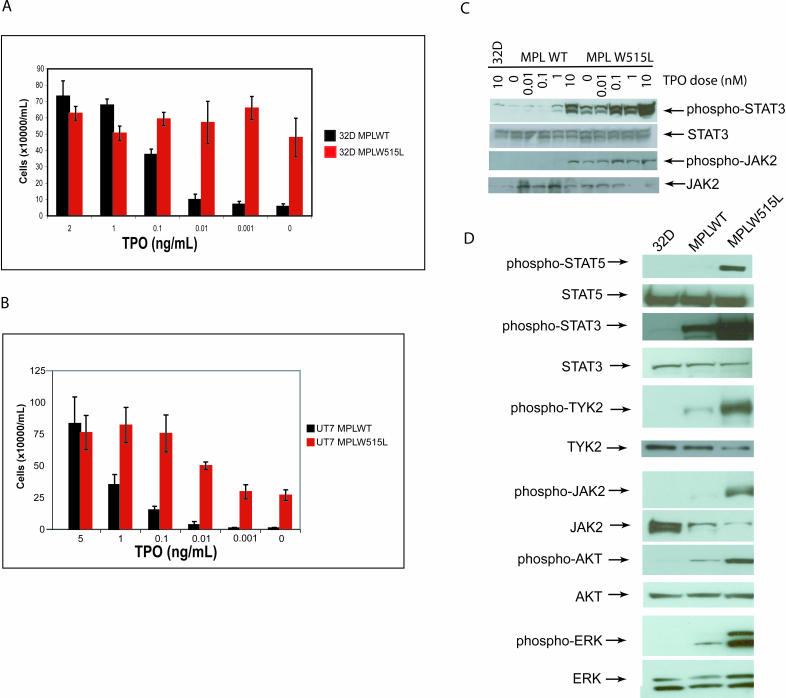
MPLW515L-Expressing Cells Show Hyper-Responsiveness to TPO(A) 32D MPLWT cells and 32D MPLW515L cells were cultured in triplicate at an initial concentration of 1 × 10
5 cells/mL, in RPMI/10% FBS containing TPO 2 ng/mL, 1 ng/mL, 0.1 ng/mL, 0.01 ng/mL, 0.001 ng/mL, or in the absence of TPO for four days, and then cell numbers were assessed. Error bars denote the standard deviation for each sample measured in triplicate.
(B) UT7 MPLWT cells and UT7 MPLW515L cells were cultured in triplicate, at an initial concentration of 1 × 10
5 cells/mL, in IMDM/10% FBS containing TPO 5 ng/mL, 1 ng/mL, 0.1 ng/mL, 0.01 ng/mL, 0.001ng/mL, or in the absence of TPO for six days, and then cell numbers were assessed. Error bars denote the standard deviation for each sample measured in triplicate.
(C) 32D MPLWT or 32D MPLW515L cells were deprived of cytokine overnight and then stimulated with TPO 5 ng/mL, 1 ng/mL, 0.1 ng/mL, 0.01 ng/mL, or without TPO for seven minutes and then analyzed by Western blot for phosphorylation of JAK2 and STAT3, demonstrating increased JAK2/STAT3 phosphorylation in response to TPO in 32D MPLW515L cells as compared with 32D-MPLWT cells.(D) Phosphorylation of JAK2, TYK2, STAT3, STAT5, AKT, and ERK in response to seven-minute stimulation with TPO (50ng/mL). 32D MPLWT or 32 MPLW515L cells were deprived of cytokine overnight and then stimulated with TPO 50 ng/mL for seven minutes and then analyzed by Western blot for phosphorylation of JAK2, TYK2, STAT3, STAT5, AKT, and ERK, demonstrating increased phosphorylation of these proteins in response to TPO in 32D MPLW515L cells as compared with 32D MPLWT cells.